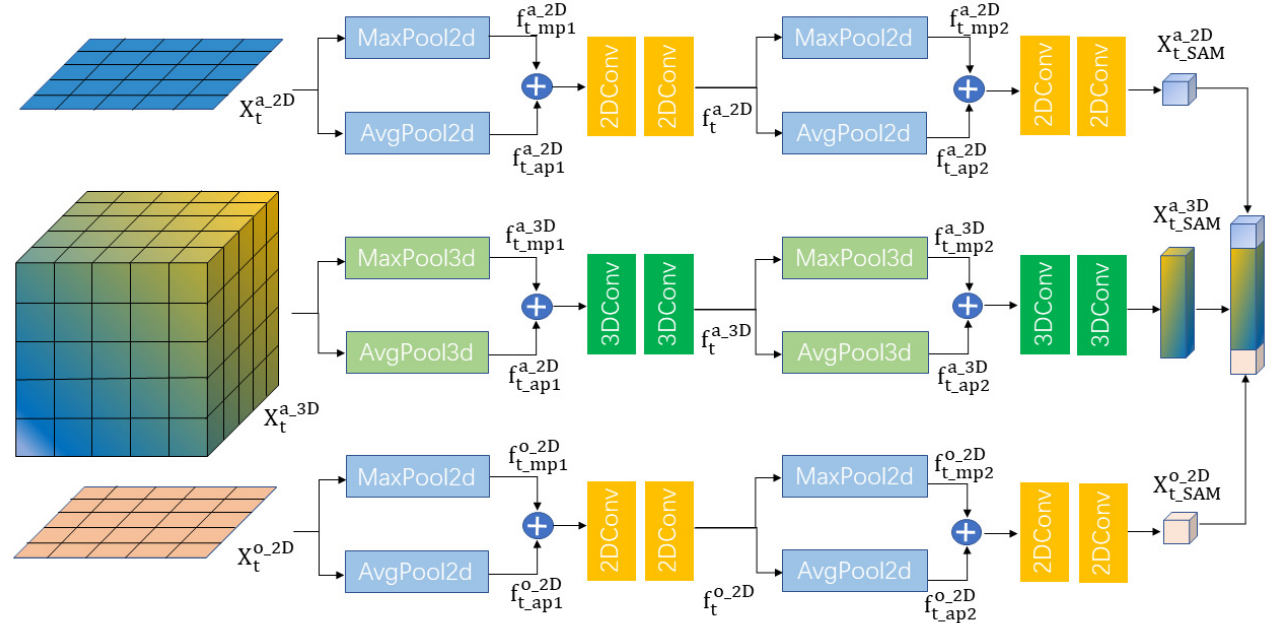
Figure 3. Detailed structure of the spatial attention module (SAM). Including MaxPool2d, AvgPool2d, MaxPool3d, AvgPool3d, 2DConv and 3DConv. From top to bottom: the feature extraction of 2D atmospheric factors, the feature extraction of 3D atmospheric factors and the feature extraction of 2D ocean